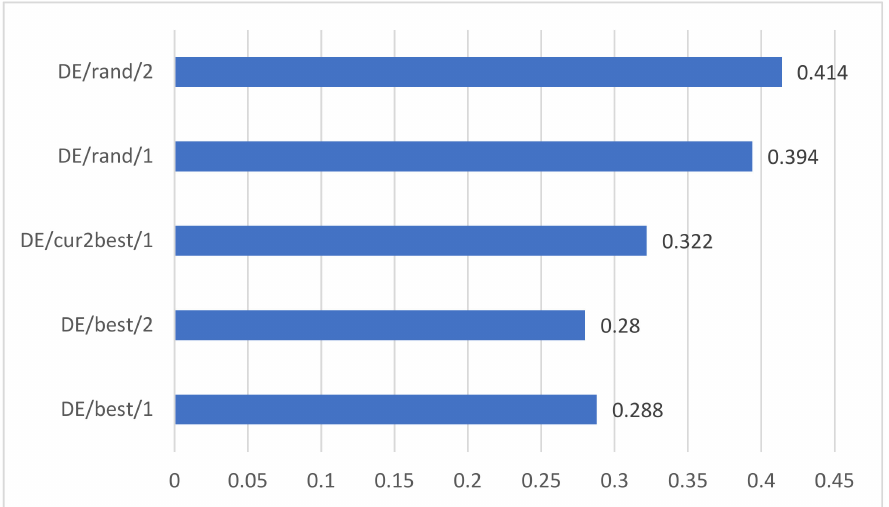
Figure 8. Convergence rate of five mutation strategies after unified dimension.